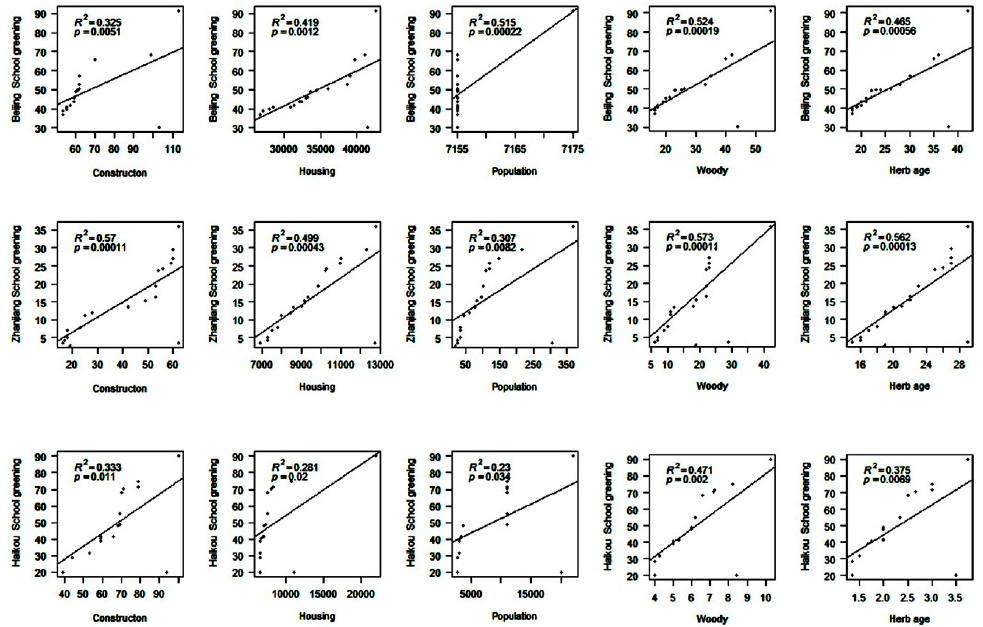
Figure 7. Scatterplots depicting the relationships between the greening percentages of Schools and both socioeconomic variables (construction age, housing price, and population density) and species richness (woody and herbaceous) within Beijing, Zhanjiang, and Haikou.